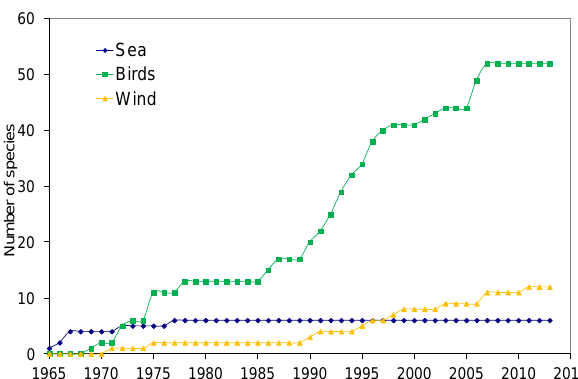
Figure 4. Cumulative curves of dispersal routes to Surtsey most probably used by different vascular plant species during the period 1965–2013. Based on dispersal-mode spectra of the flora and sites of establishment on the island.